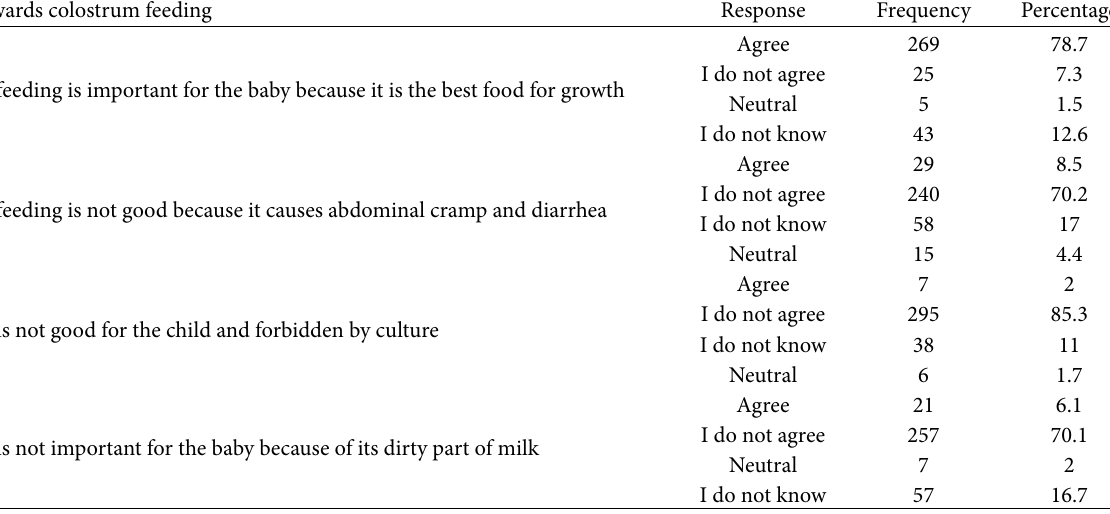
Table 4: Mother’s attitude towards colostrum feeding in Gununo Health Center, Wolaita Zone, SNNP Region, Southern Ethiopia, 2019. Attitude towards colostrum